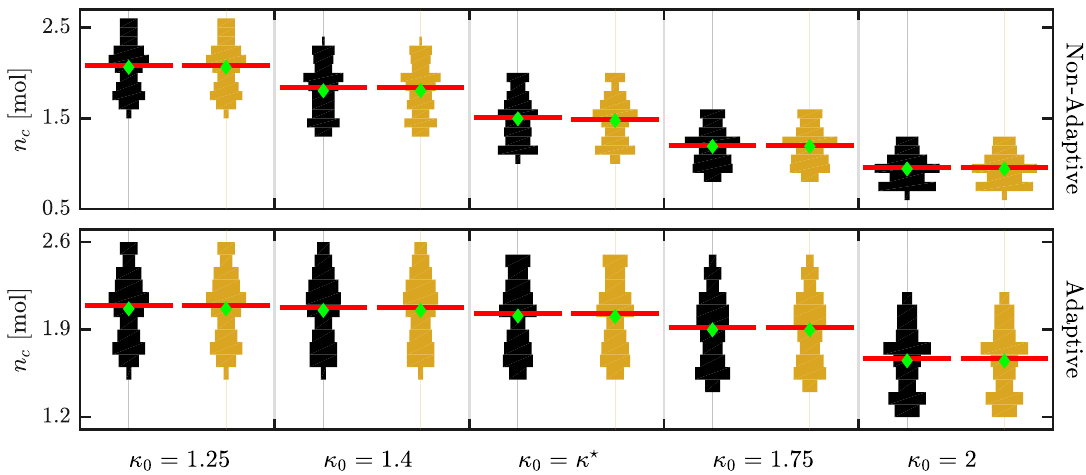
Figure 11. Violin plot of the amount of product C produced in the first 0.3 h using MS-SB, A-MS-SB, MS-CB, and A-MS-CB NMPC schemes with different values of the scaling factor considered at the first stage ( κ 0 ) in the absence of measurement noise. represents MS-SB NMPC, A-MS-SB NMPC, and represents MS-CB NMPC, A-MS-CB NMPC. and represent the mean and the median value.